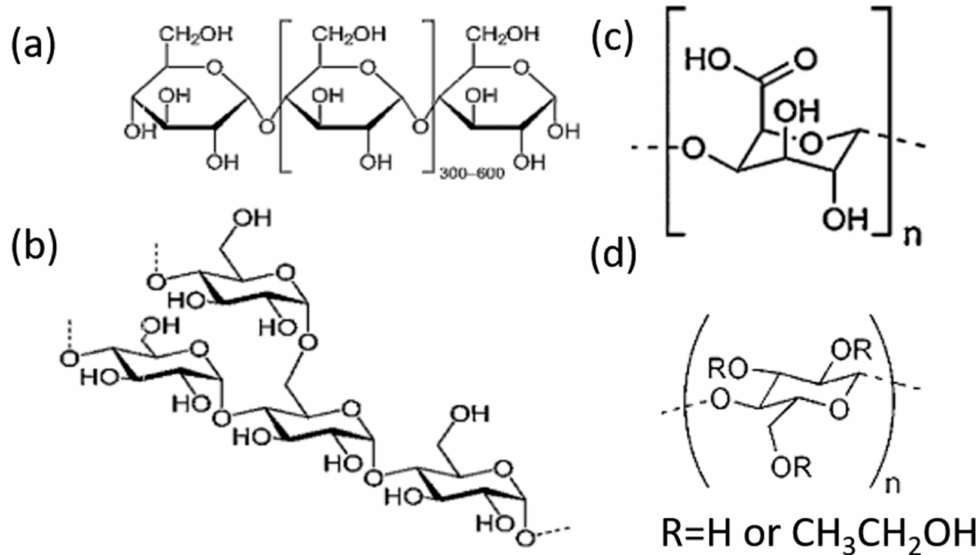
Figure 8. Chemical structures of the amylose ( a ), amylopectin ( b ), Pectin ( c ), and hydroxypropyl cellulose ( d